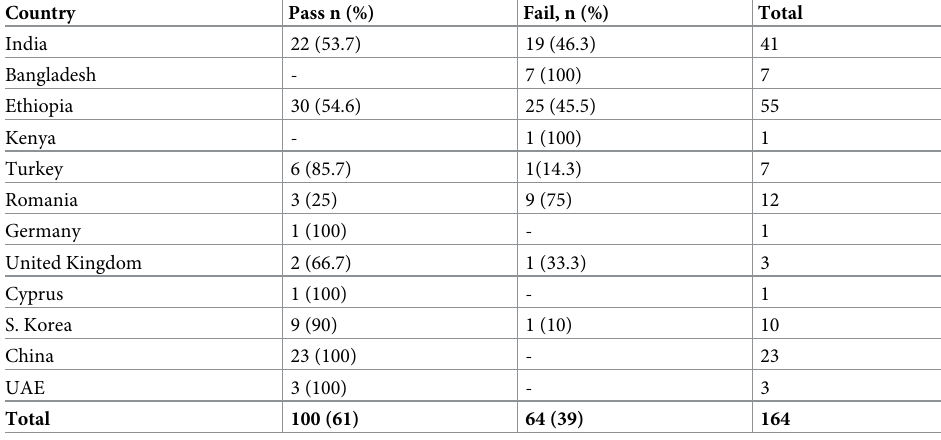
UAE: United Arab Emirates, S. Korea: South